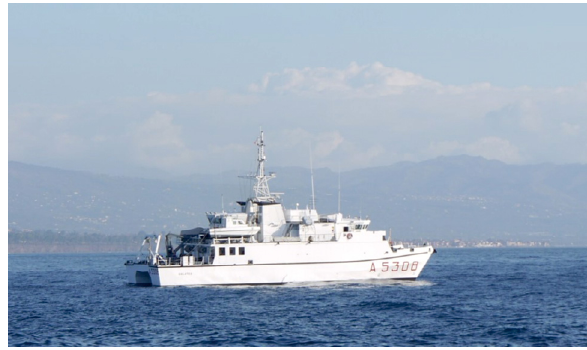
Figure 1. The catamaran H/V “Galatea” by Italian Navy.